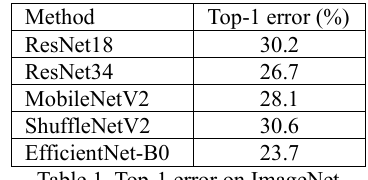
Table 1. Top-1 error on ImageNet